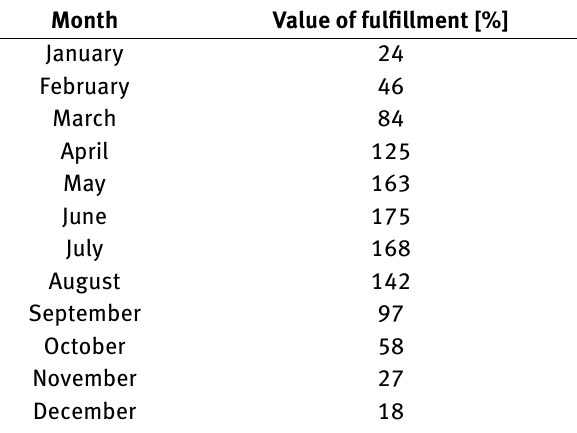
Table 7: Daily energy consumed by collectors in given months (Variant II).